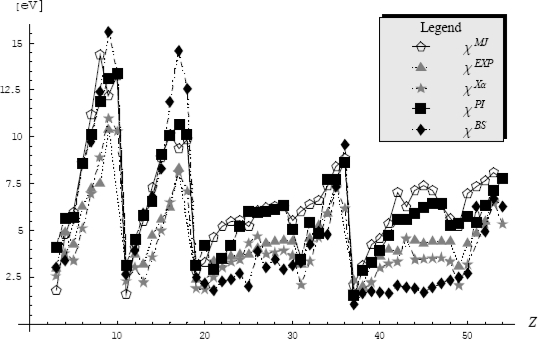
The comparative representation of the atomic electronegativities of Mulliken-Jaffe (MJ), experimental (EXP), and transition state (Xα) respecting the chemical Mulliken one (400) with the recorded values of Table 4 by path integral (PI) and basis set (BS) methods.